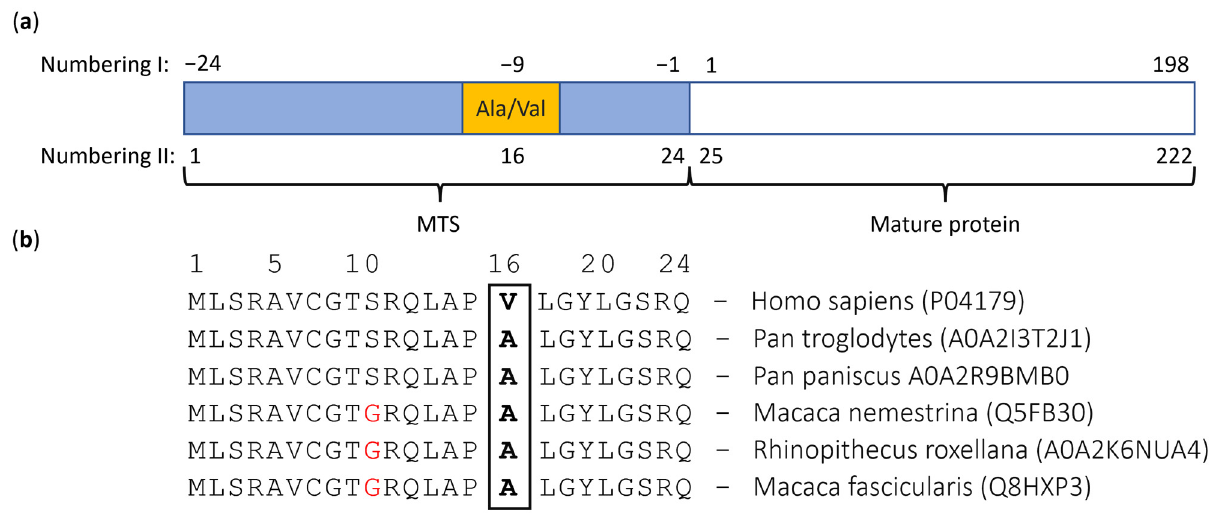
Figure 2. A schematic representation of the different systems of numbering and the conservation of the MTS sequence in homo sapiens and other primate species. ( a ) MTS (blue), Ala16Val (yellow), and mature MnSOD (white). The protein residues can be numbered with respect to the initial residue of the mature protein (numbering I) or with respect to the initial residue of the MTS of the immature protein (numbering II). Consequently, the Ala-9Val (numbering I) is equivalent to the Ala16Val (numbering II). ( b ) The MTS sequence shows high interspecies conservation. Red letters represent the amino acids that differ from the human MTS of MnSOD, while the bolded letter represents the location of the Ala16Val substitution. In all other primate species, only alanine can be found in position 16; the same trend can also be observed for most more distant species (Figure S3J).